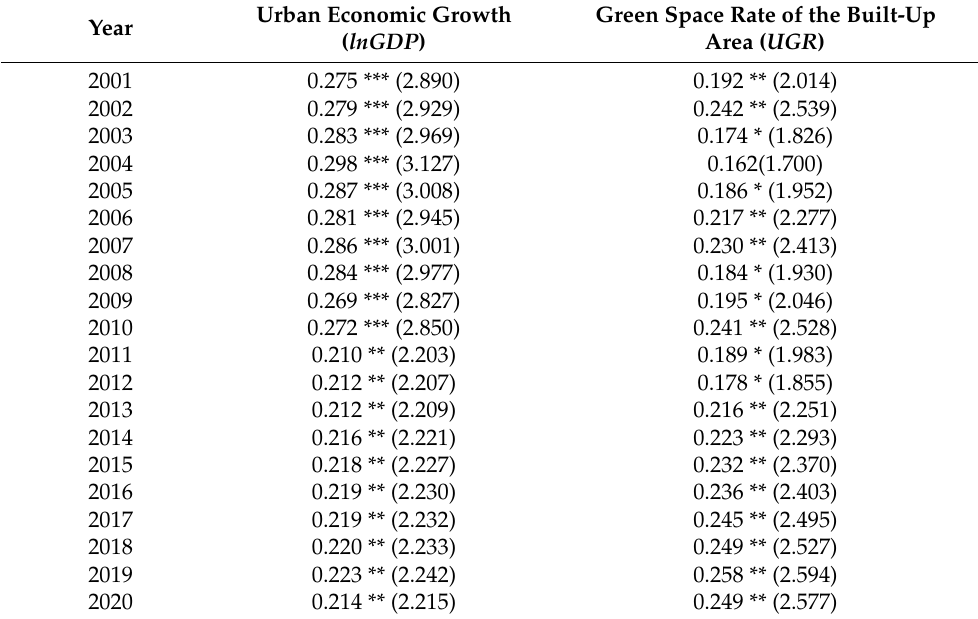
Table 5. Global Moran’s I index of main variables over the past decades. Urban Economic Growth Green Space Rate of the Year ( lnGDP )